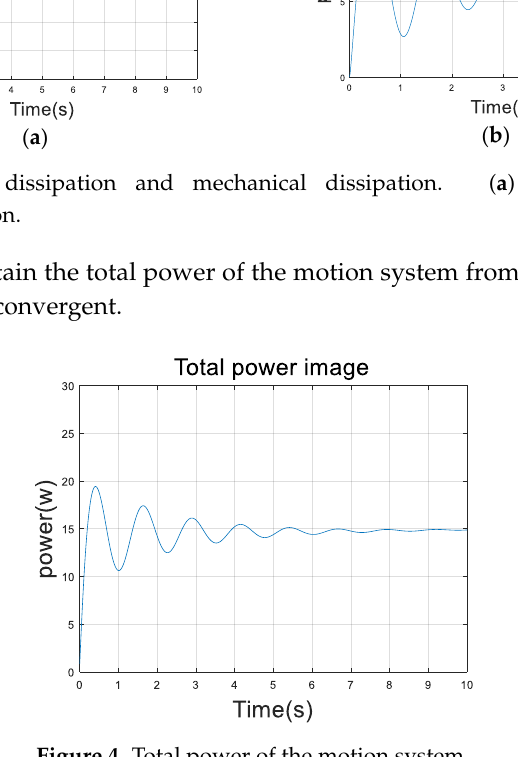
Figure 4. Total power of the motion system.